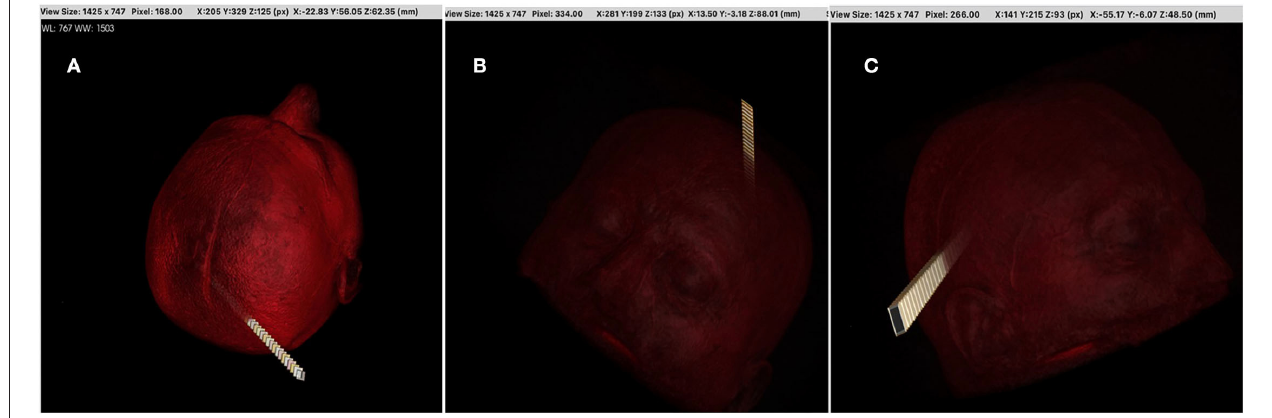
FIGURE 4 | The research algorithm was created for time efficiency compared with the time-consuming RL algorithm. The goal is to find the most ideal cranial entry points. Machine learning was not used in this method. Cranial entry points were scored using the equivalent areas and tumor location in Table 1 and compared with each other. With this algorithm, it was possible to sort by five most ideal entry points, 10 entry points, or worst entry points. In addition, this algorithm provided a linear access path to tumor tissue in the shape of a rectangular prism or cylinder. The entrance area in the images was determined as 1.5 cm 2 . The algorithm has been adjusted to allow this area to be increased or decreased. This algorithm can be useful in tubular operative systems or rigid endoscopic systems. In this study, we took these points (the most ideal 4,900 points) as the starting points of RL. Image (A,B) are the ideal best rated and image (C) the worst-rated sample entry points.